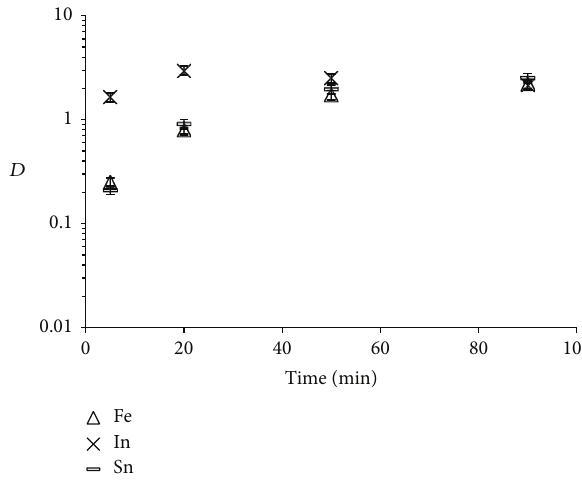
Figure 1: Kinetics of metal extraction using 1M H 2 SO 4 and 0.1M D2EHPA in kerosene, 𝜃 = 1 . Mixing time of the mixtures was between 5 minutes and 2.5 hours under mechanical shaking at 1500 rpm and 293 ± 1K.